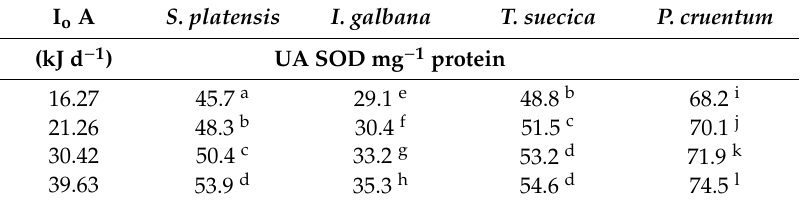
Table 9. UA of SOD in microalgae in continuous cultures at di ff erent light intensities. I o A